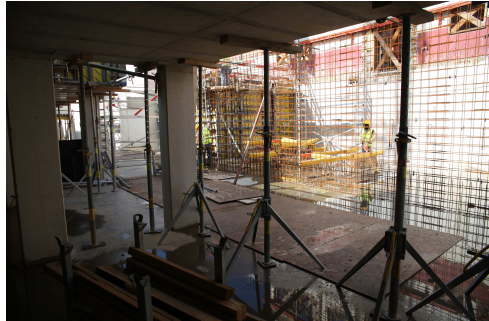
Figure 4: Narrow spaces at construction sites are hard to record with normal lenses and complicate the alignment process